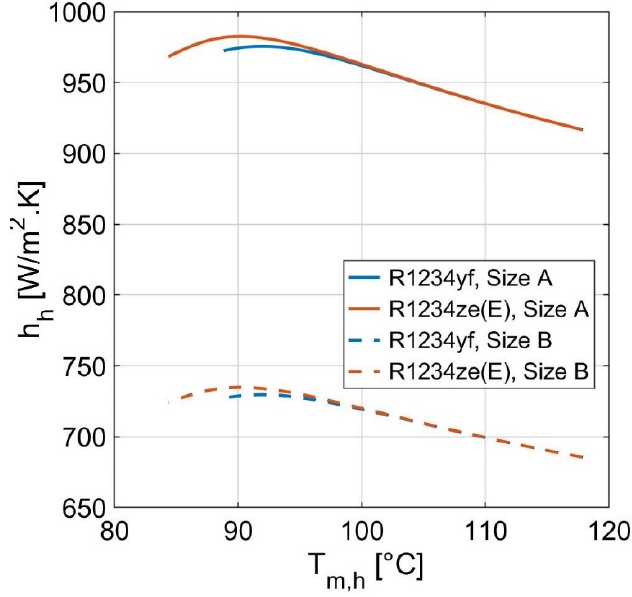
Figure 15. Hot stream convection coefficient at different plate sizes: size A (marked with solid lines) and size B (marked with dashed lines) at various mean hot stream temperatures.